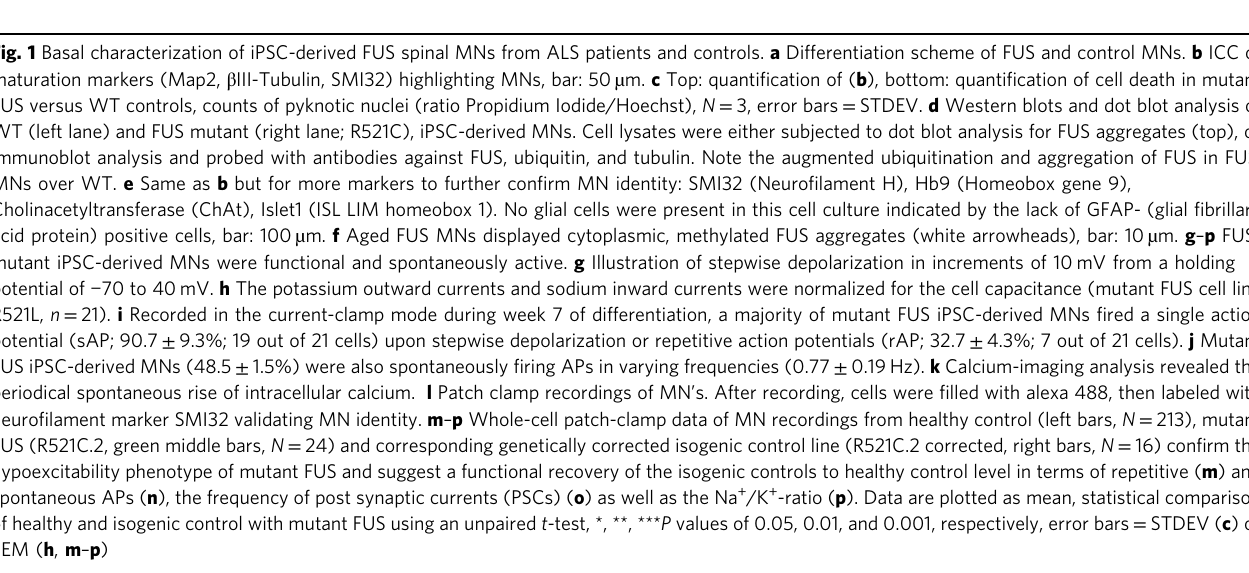
Fig. 1 Basal characterization of iPSC-derived FUS spinal MNs from ALS patients and controls. a Differentiation scheme of FUS and control MNs. b ICC of maturation markers (Map2, β III-Tubulin, SMI32) highlighting MNs, bar: 50 µ m. c Top: quanti fi cation of ( b ), bottom: quanti fi cation of cell death in mutant FUS versus WT controls, counts of pyknotic nuclei (ratio Propidium Iodide/Hoechst), N = 3, error bars = STDEV. d Western blots and dot blot analysis of WT (left lane) and FUS mutant (right lane; R521C), iPSC-derived MNs. Cell lysates were either subjected to dot blot analysis for FUS aggregates (top), or immunoblot analysis and probed with antibodies against FUS, ubiquitin, and tubulin. Note the augmented ubiquitination and aggregation of FUS in FUS MNs over WT. e Same as b but for more markers to further con fi rm MN identity: SMI32 (Neuro fi lament H), Hb9 (Homeobox gene 9), Cholinacetyltransferase (ChAt), Islet1 (ISL LIM homeobox 1). No glial cells were present in this cell culture indicated by the lack of GFAP- (glial fi brillary acid protein) positive cells, bar: 100 µ m. f Aged FUS MNs displayed cytoplasmic, methylated FUS aggregates (white arrowheads), bar: 10 µ m. g – p FUS mutant iPSC-derived MNs were functional and spontaneously active. g Illustration of stepwise depolarization in increments of 10 mV from a holding potential of − 70 to 40 mV. h The potassium outward currents and sodium inward currents were normalized for the cell capacitance (mutant FUS cell line R521L, n = 21). i Recorded in the current-clamp mode during week 7 of differentiation, a majority of mutant FUS iPSC-derived MNs fi red a single action potential (sAP; 90.7 ± 9.3%; 19 out of 21 cells) upon stepwise depolarization or repetitive action potentials (rAP; 32.7 ± 4.3%; 7 out of 21 cells). j Mutant FUS iPSC-derived MNs (48.5 ± 1.5%) were also spontaneously fi ring APs in varying frequencies (0.77 ± 0.19 Hz). k Calcium-imaging analysis revealed the periodical spontaneous rise of intracellular calcium. l Patch clamp recordings of MN ’ s. After recording, cells were fi lled with alexa 488, then labeled with FUS (R521C.2, green middle bars, N = 24) and corresponding genetically corrected isogenic control line (R521C.2 corrected, right bars, N = 16) con fi rm